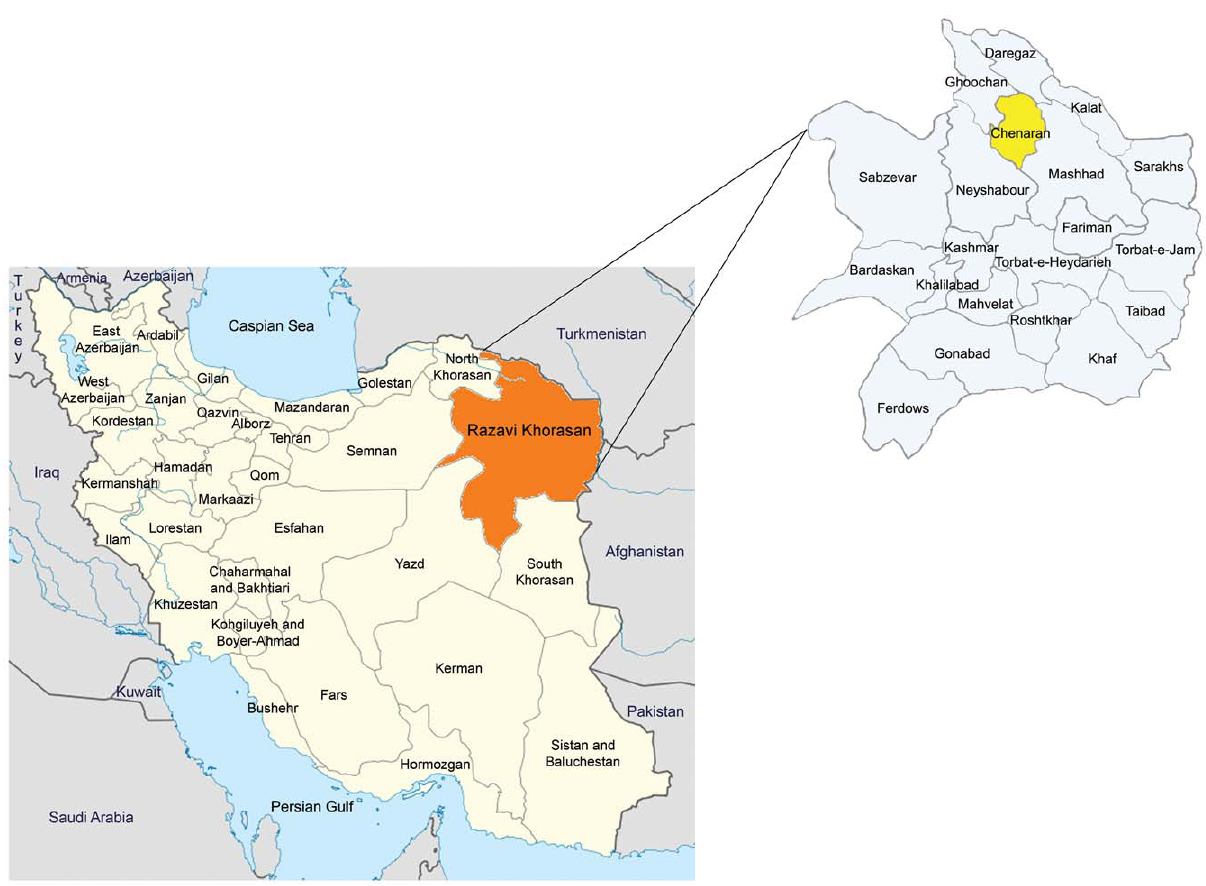
Figure 1. Map of Iran. Razavi Khorasan Province is indicated by orange. The study area, Chenaran County, is highlighted with yellow. Based on the map of Razavi Khorasan Province at http://en.wikipedia.org/wiki/File:Locator_map_Iran_Razavi_Khorasan_Province.png by Uwe Dering, highlighted by Dr. Blofeld.